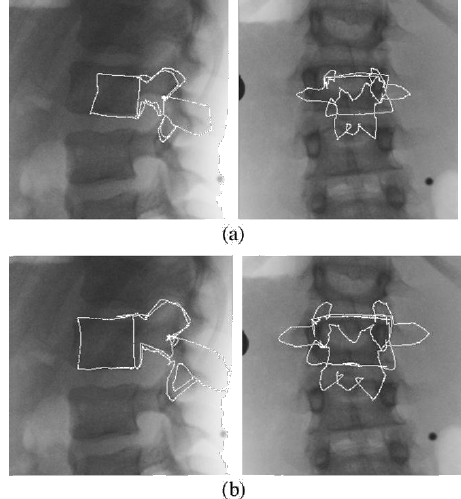
Figure 8. Projection of vertebra template on corresponding vertebra PA and LAT views (a) Initial (b) after deformations; Source: (Benameur et al., 2005)